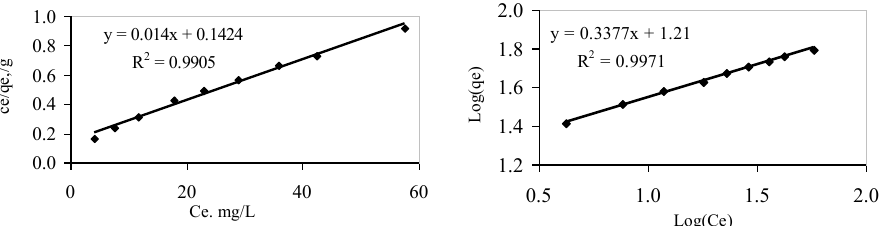
Figure 8. Freundlich adsorption isotherm of U(VI) onto STH (pH=6.5,